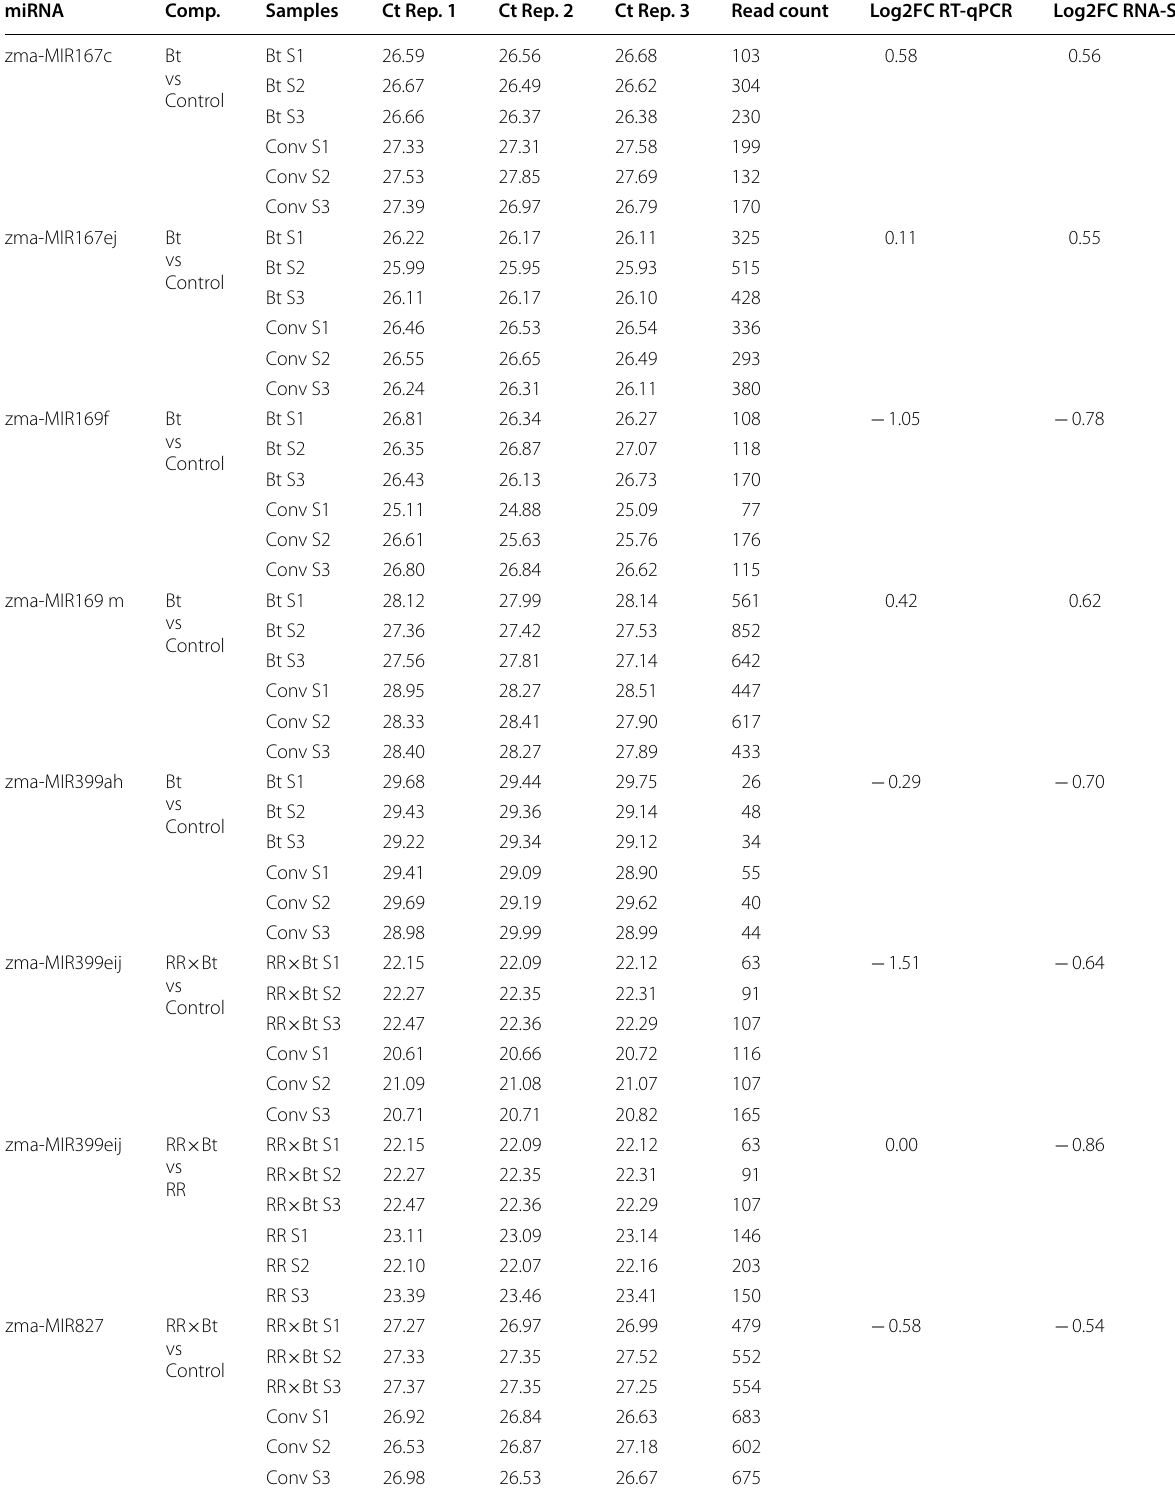
Table 3 Comparative data of RT-qPCR and RNA-Seq for 7 differentially expressed conserved miRNAs miRNA Comp. Samples Ct Rep. 1 Ct Rep. 2 Ct Rep. 3 Read count Log2FC RT‑qPCR Log2FC